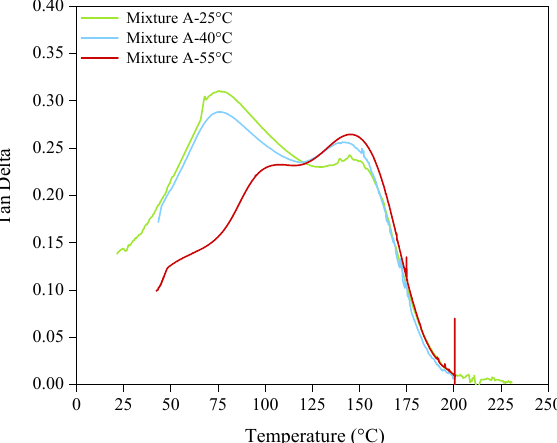
Figure 8. An example of the bimodal Tan delta curves obtained by DMA. The T g of the mixtures were defined by the peak of tan δ curves.